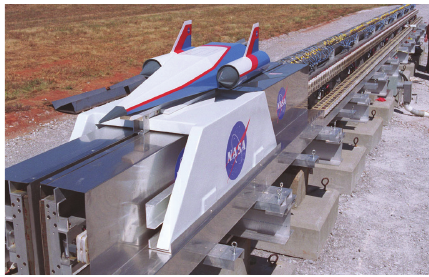
Figure 16: Different technologies to push a spacecraft down a long rail have been tested in several settings, including this Magnetic Levitation (Maglev) System evaluated at NASA’s Marshall Space Flight Center. Engineers have a number of options to choose from as their designs progress. Photo credit: NASA.